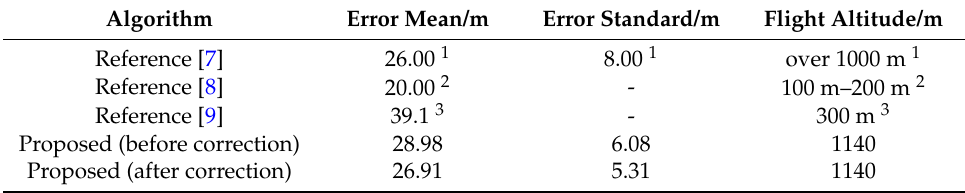
Figure 14. Plane localization errors after RLS filtering. By comparing the results after the stabilization of RLS filtration with the nominal geodetic coordinates of each target, the geo-location errors of geodetic coordinates of the targets after RLS filtration can be determined, as shown in Table 7.